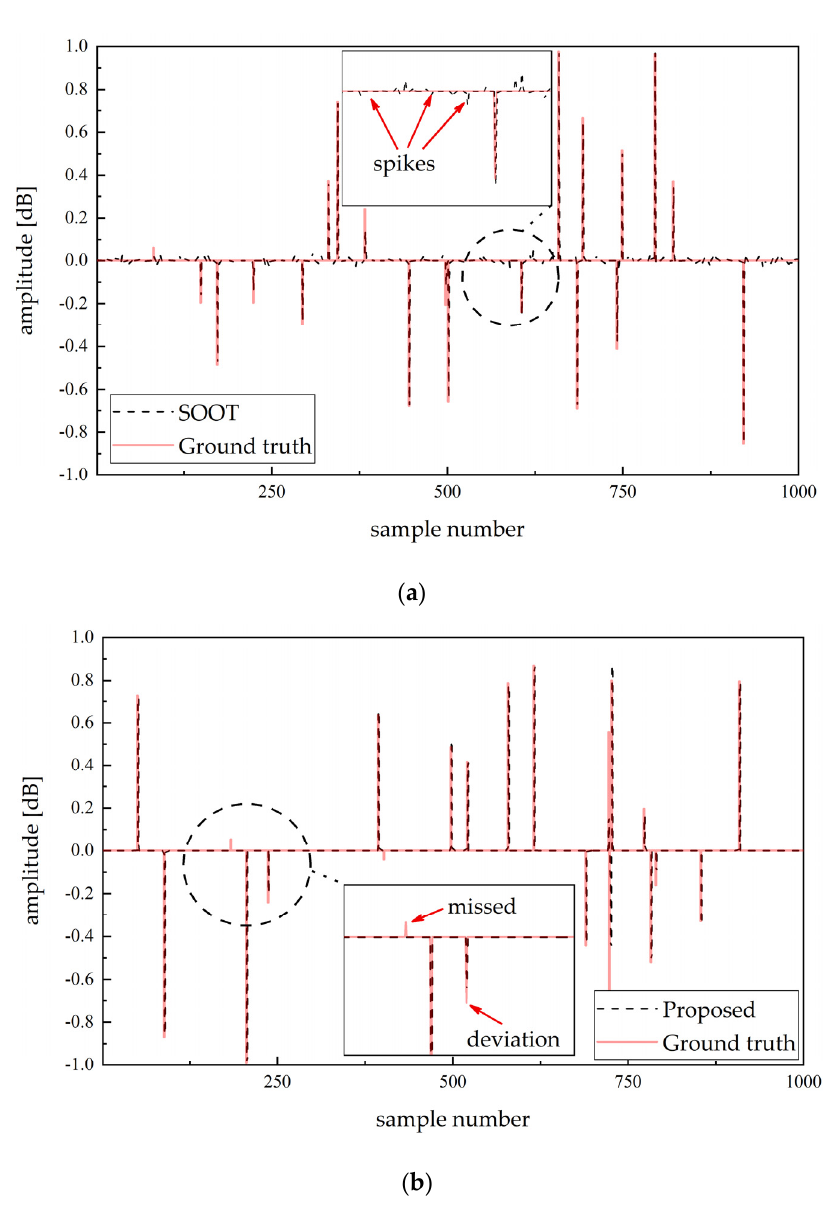
Figure Figure 5. Deconvolution results of different methods with optimization theory: ( a ) SOOT; ( b ) proposed algorithm.